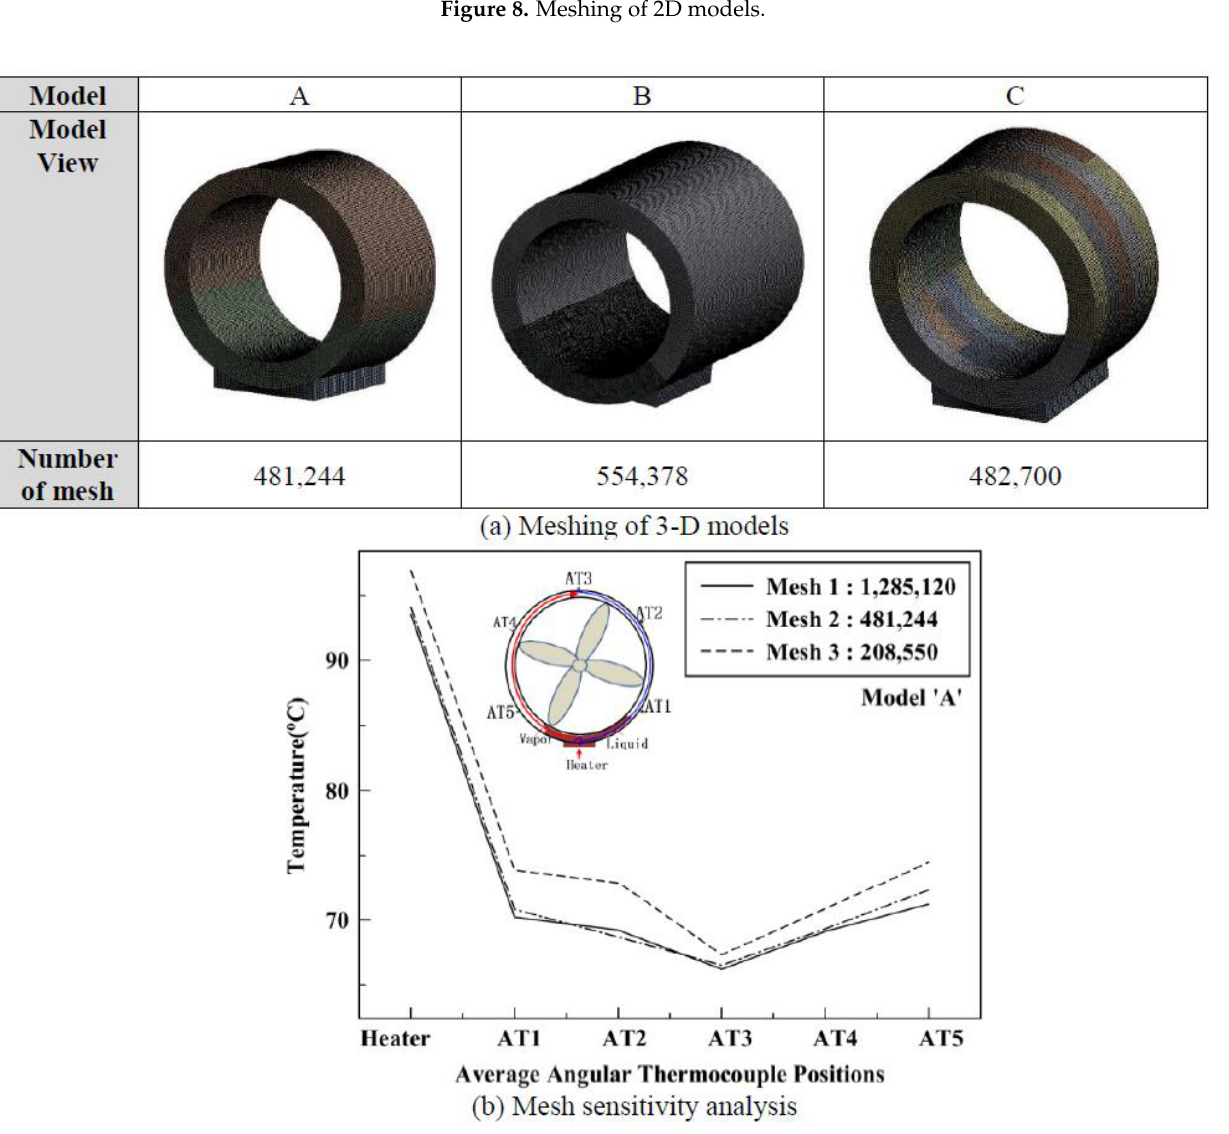
Figure 8. Meshing of 2D models.